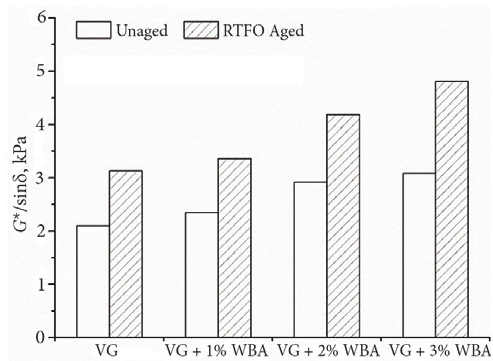
Figure 3. Viscosity results at 135 °C